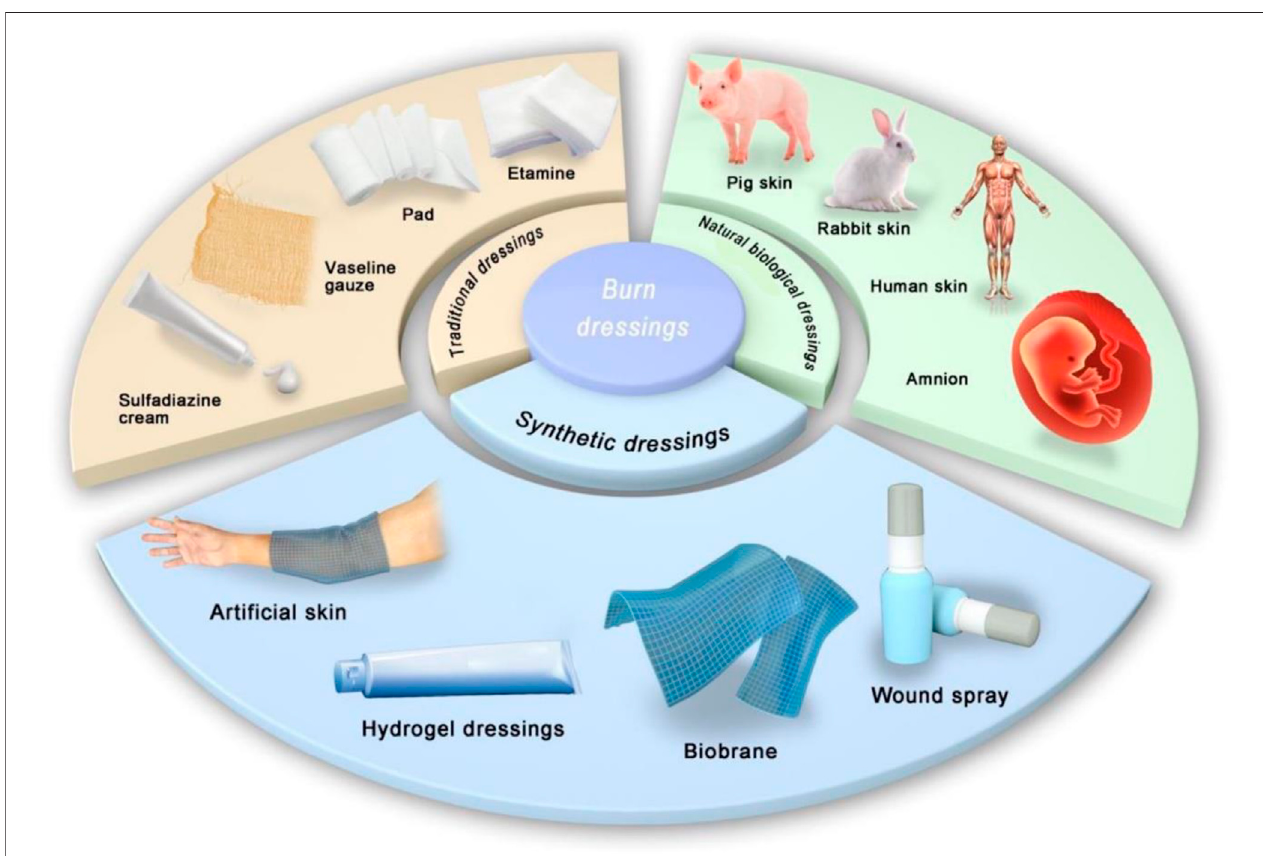
FIGURE 2 | Classi fi cation of burn dressings: Traditional dressings, Natural biological dressings, and Synthetic dressings.